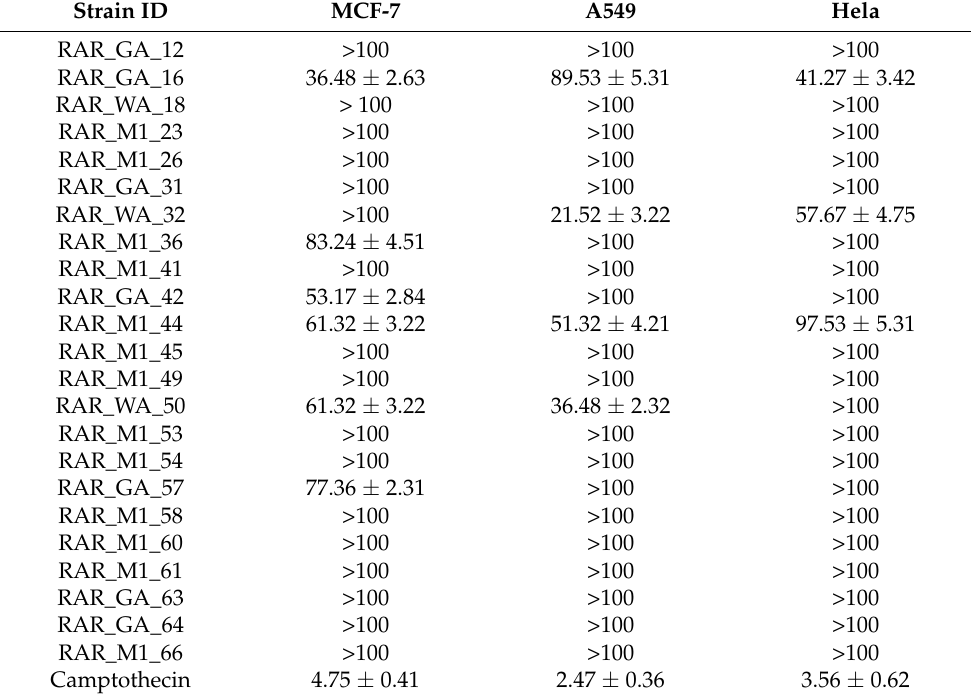
Table 5. Cytotoxic activity of bacterial extracts against cancer cell lines (IC 50 , µ g/mL). Strain